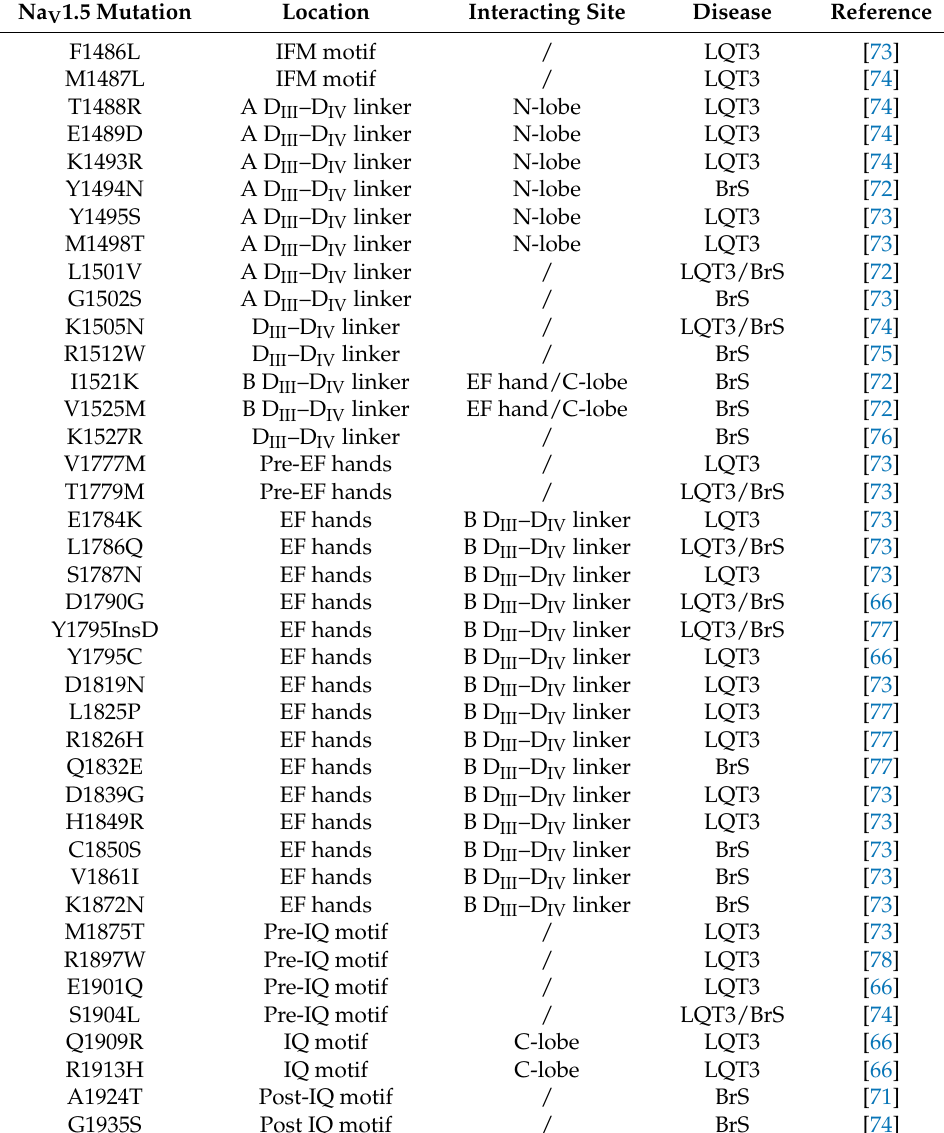
Table 1. Mutations in Na V 1.5 channels influencing CaM binding. LQT3: long QT syndrome type 3; BrS: Brugada syndrome; IFM motif: inactivation motif; A D III –D IV linker: A CaM binding domain within the D III –D IV linker; B D III –D IV linker: B CaM binding B domain within the D III –D IV